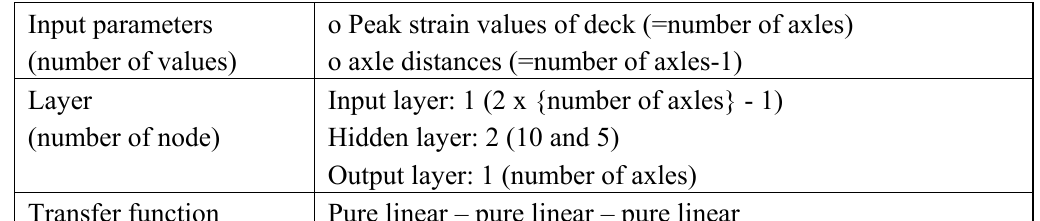
Table 4. Structure of ANN for AWDF